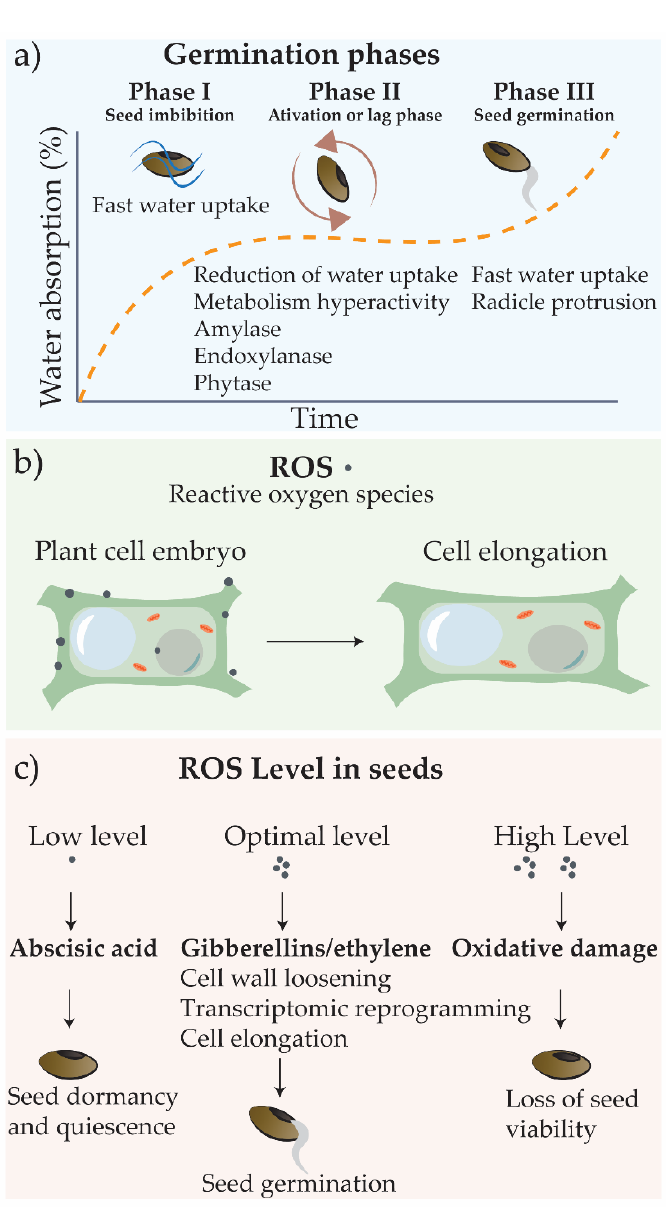
Figure 2. Germination phases and reactive oxygen species (ROS) effects. ( a ) The germination process is subdivided into three phases: phase I (water uptake), phase II (metabolic activity, with initiation of degradation of starch reserves and preparation for embryo development), and phase III (embryo development and emergence of the radicle). ( b ) The ROS act by destabilizing cell wall, allowing water uptake and cell elongation; ( c ) ROS level in seeds and hormones production.